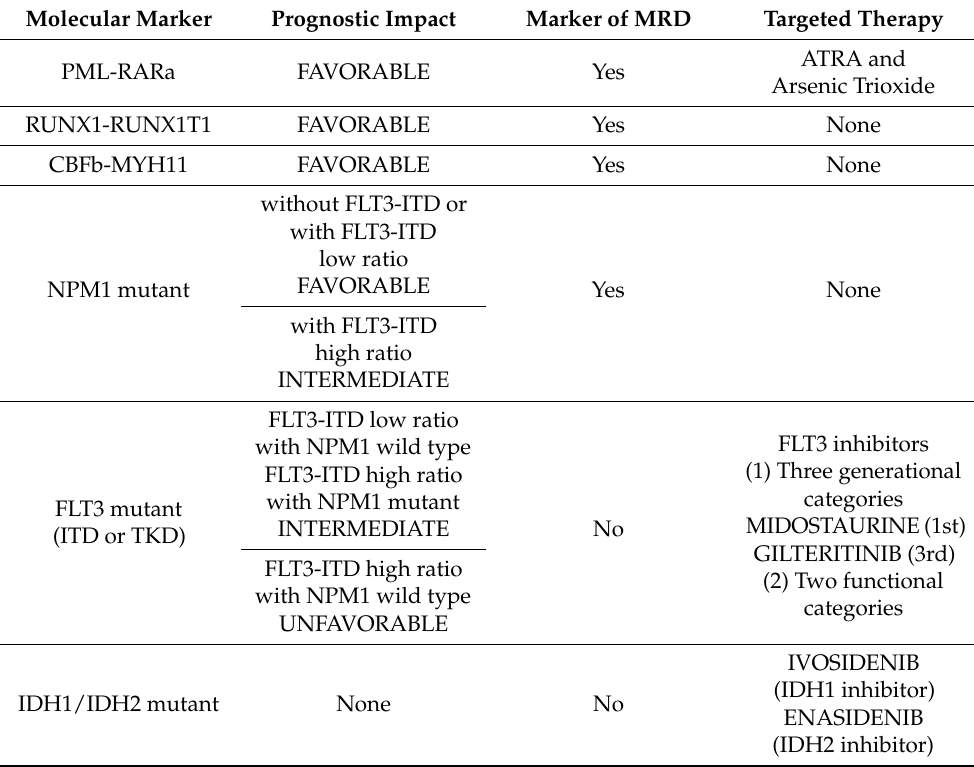
Table 1 highlights the clinical relevance of the main contributions of descriptive genomics in AML. Table 1. Clinical relevance of descriptive genomics in AML. Examples of genetic alterations, their prognostic impact and their potential use as a response MRD marker and/or therapeutic target. Molecular